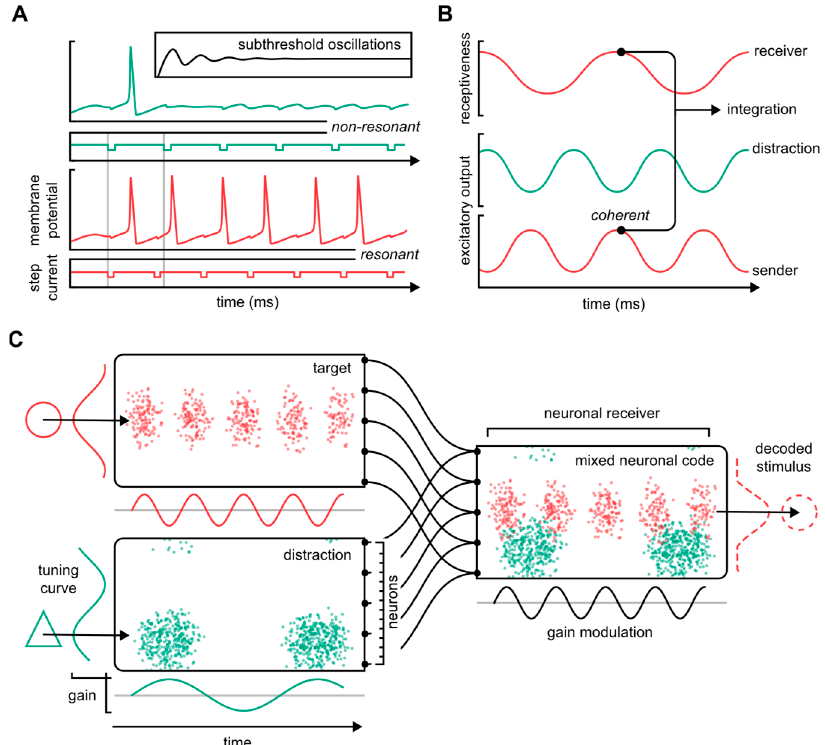
Figure 2. Neuronal dynamics. ( A ) Resonance of the neuronal membrane potential facilitates the selective transfer of information. The traces show a Hodgkin–Huxley neuron receiving step current pulses at two different frequencies (green: low frequency—red: high frequency). When the pulses do not resonate with the neuron’s underlying resonance tendency, the signals are poorly integrated (green). When pulses do resonate, the neuron integrates and transmits the signals onward (red). The inset shows spontaneous subthreshold oscillations. ( B ) In the “communication through coherence”- framework, neuronal inputs systematically arrive at moments of high receptiveness, or input gain. ( C ) Oscillation-based neuronal communication differentiated by frequency enables the multiplexing of information. The figure is based on a model originally described by Akam and Kullmann [23]. Two neuronal populations with differing stimulus sensitivities (“tuning curves”) connect to the same post-synaptic neuronal receiver. The mixed neuronal code is decoded via the receiver’s input gain that matches the target stimulus input train. Red: target. Green: distraction.